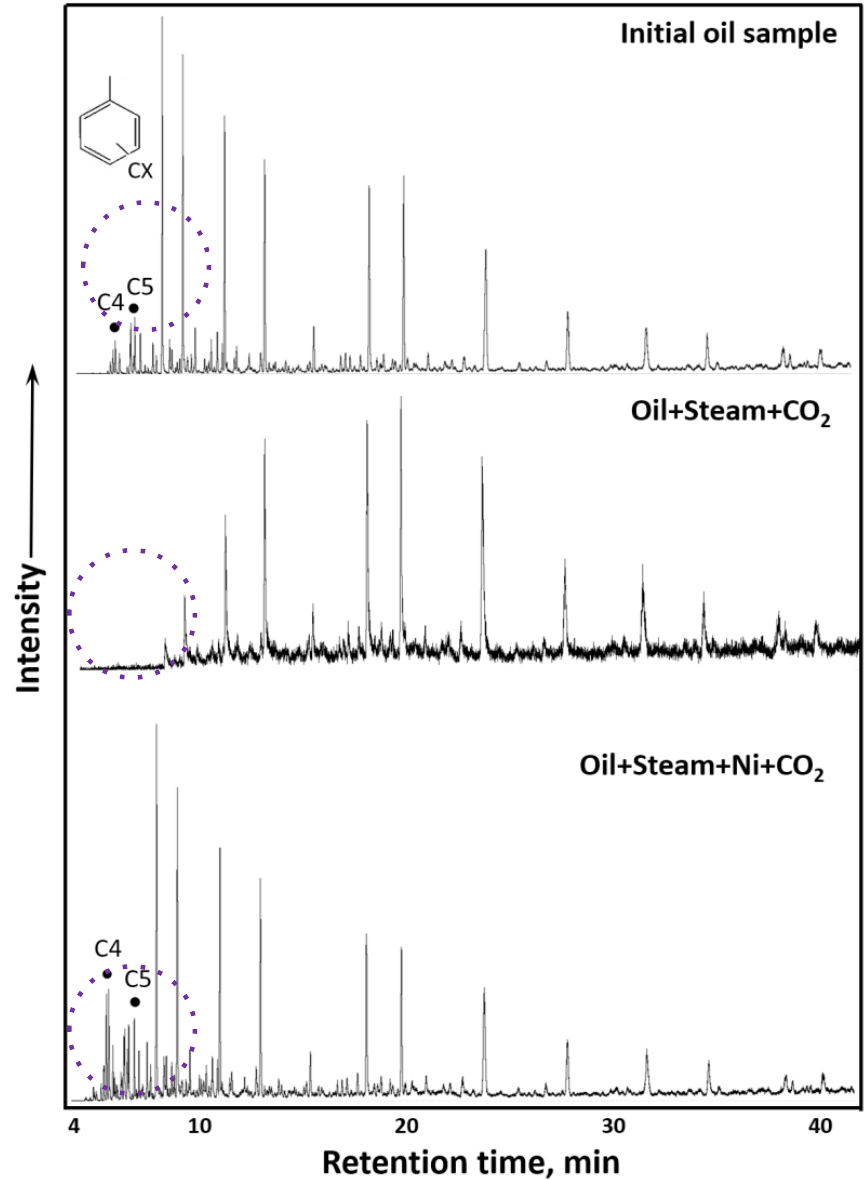
Figure 6. GC-MS spectra of 1,3,4-trimethyl-2-alkylbenzenes.